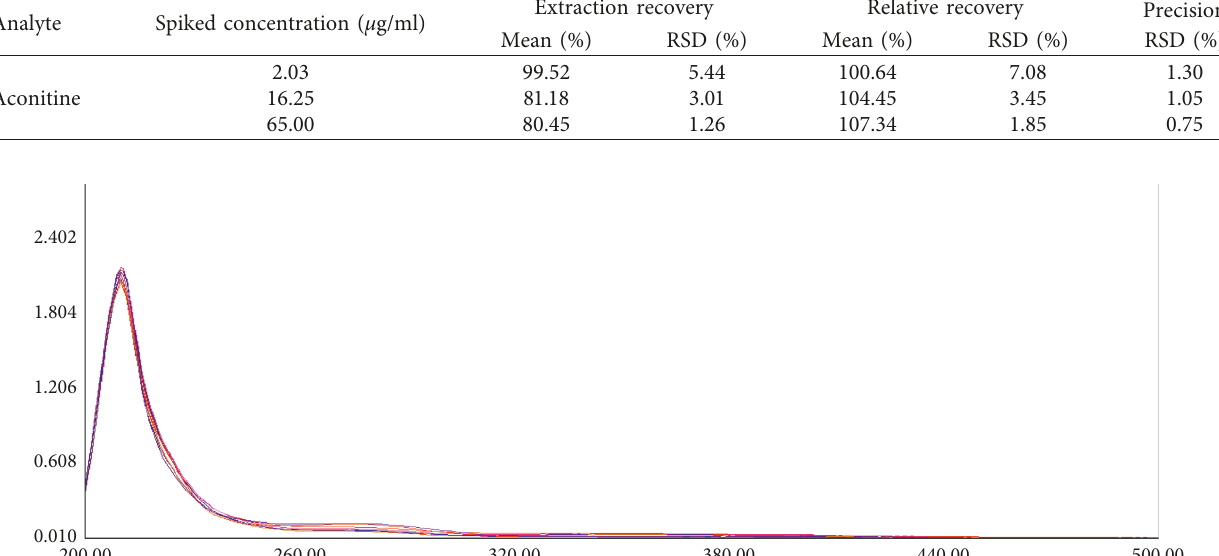
Figure 4: The spectrum of blank plasma from randomized rats in single dose ( n